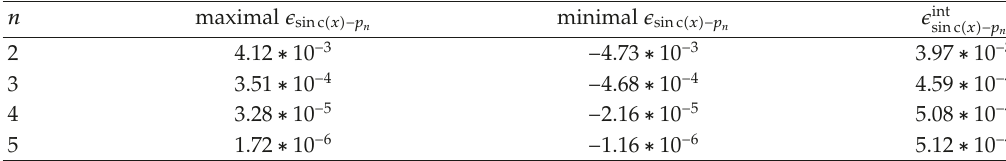
and integration error (cid:5) int between the approximating sin c (cid:2) x (cid:6) − p n n